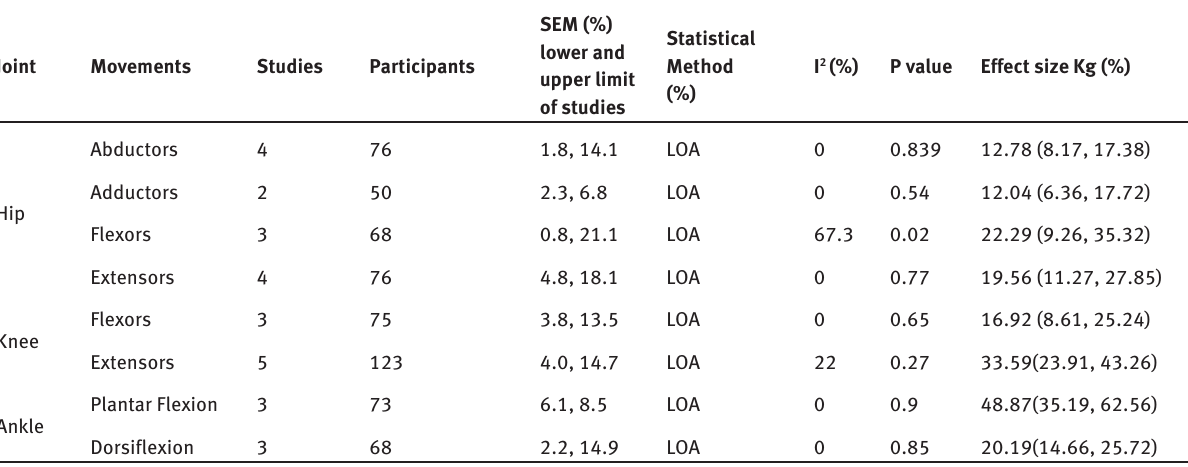
Table 7: Maximal voluntary isometric strength LOA for inter-subject variability between trials: hip, knee, and ankle muscles measured with HHD